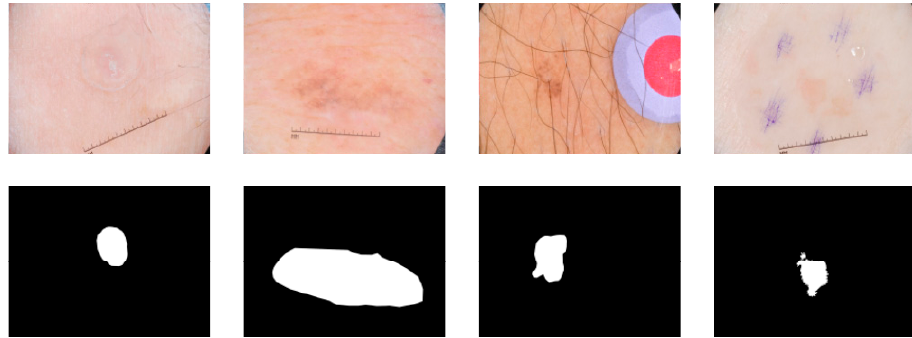
Figure 1. Several examples of skin lesions that are difficult to isolate